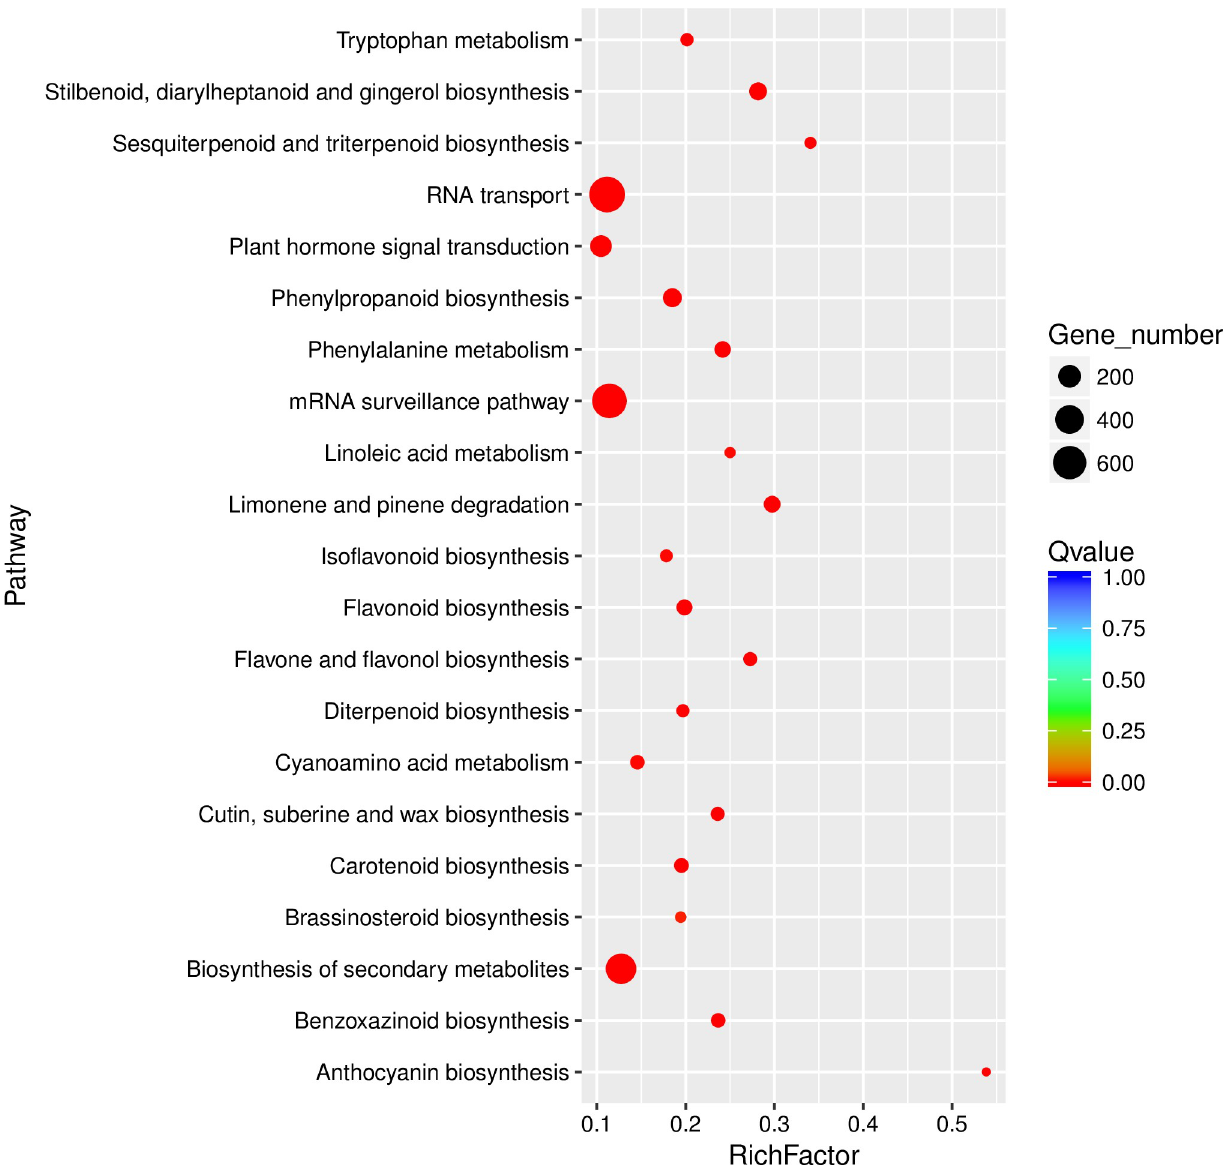
Fig 6. GO term enrichment analysis of DEGs of Coix lacryma-jobi L.